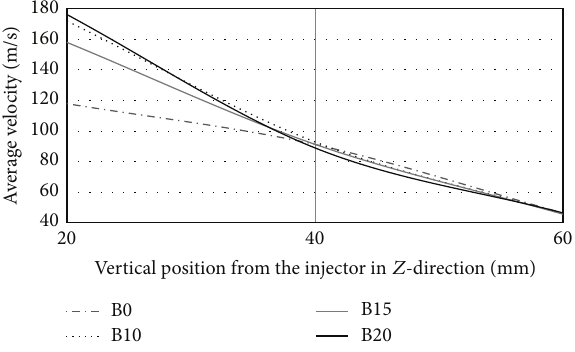
Figure 22: Average velocity in 𝑍 -direction for different HFO/n- butanol blends at injection pressure of 600bar on different vertical positions from the injector.